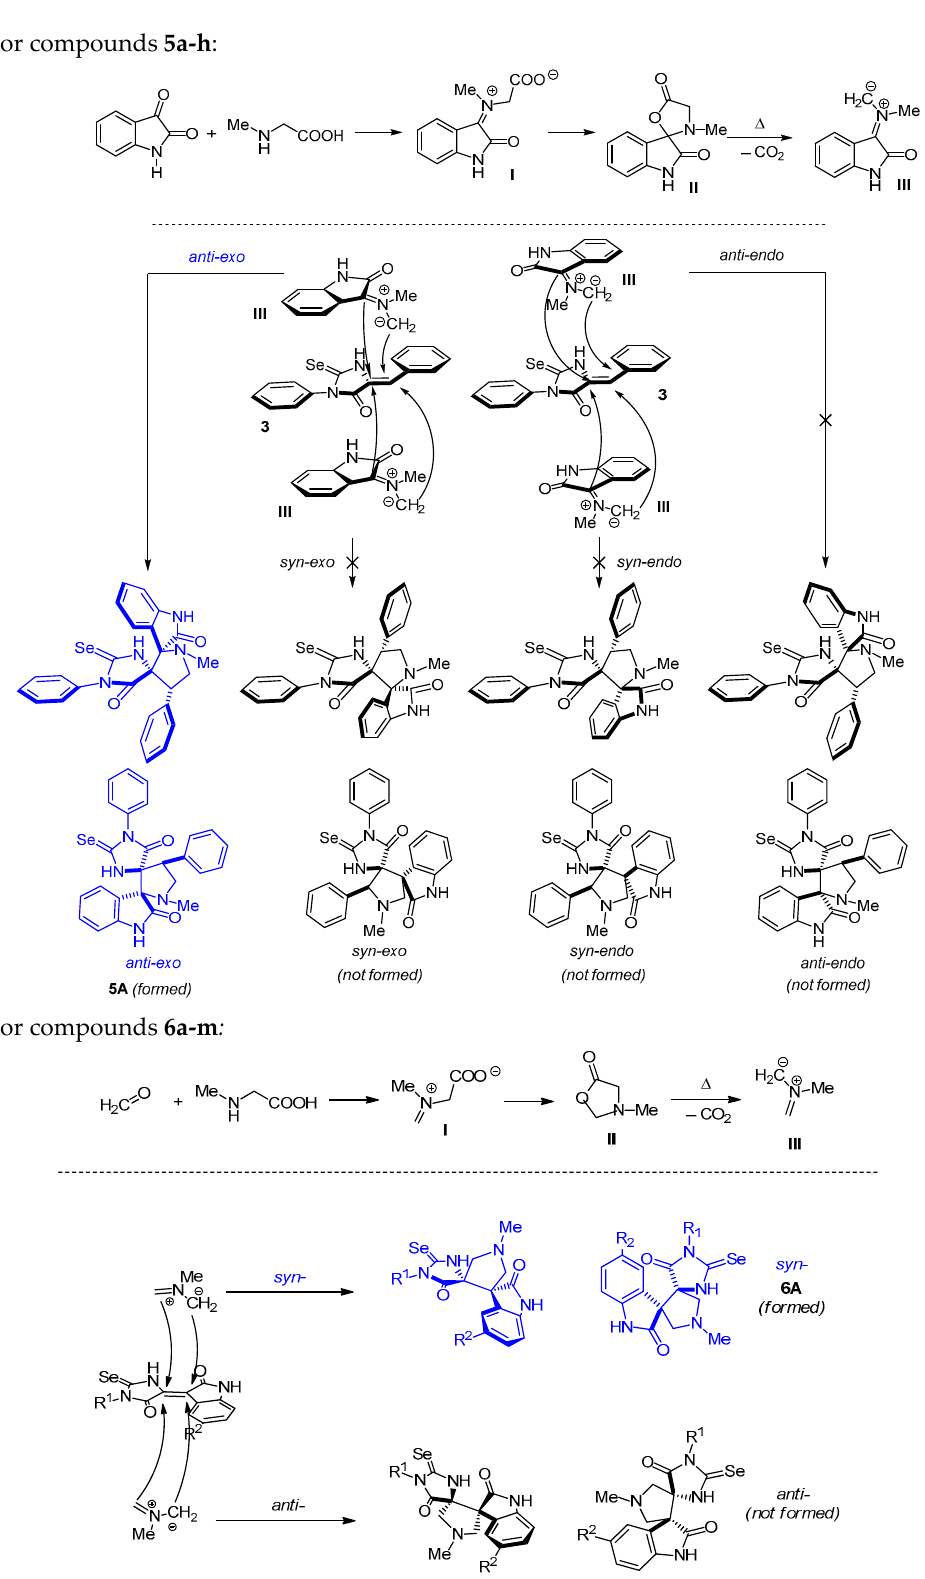
Scheme 6. The supposed mechanism of the formation of dispiro derivatives 5a-h and 6a-m . The formation of dispiroselenoindolinones 6a-m apparently took place similarly to compounds 5a-h through the following steps (Scheme 6): (1) the reaction between isatin and amino acid with the formation of an iminium intermediate, (2) the cyclization of